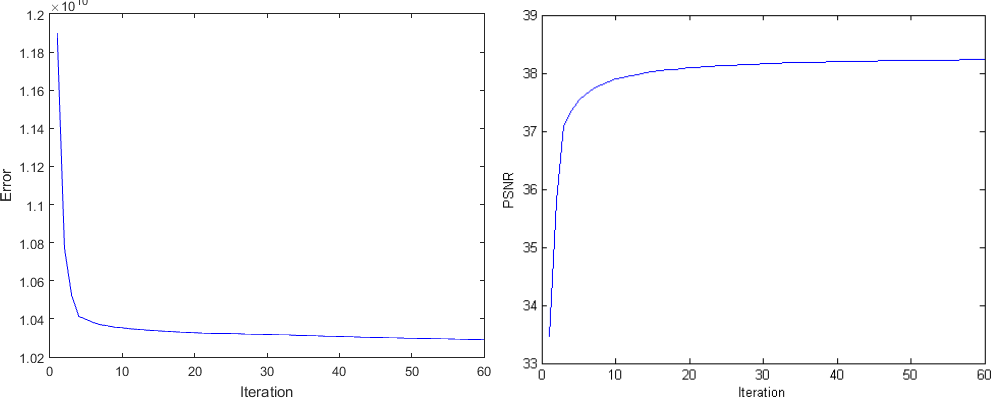
Figure 1. Convergence analysis. The X -labels are the iteration number. The Y -labels are the is the objective function of System (20) (left) and the restoration result (measured by ’PSNR’) (right). It is shown that our dictionary pair learning algorithm is a convergence one.